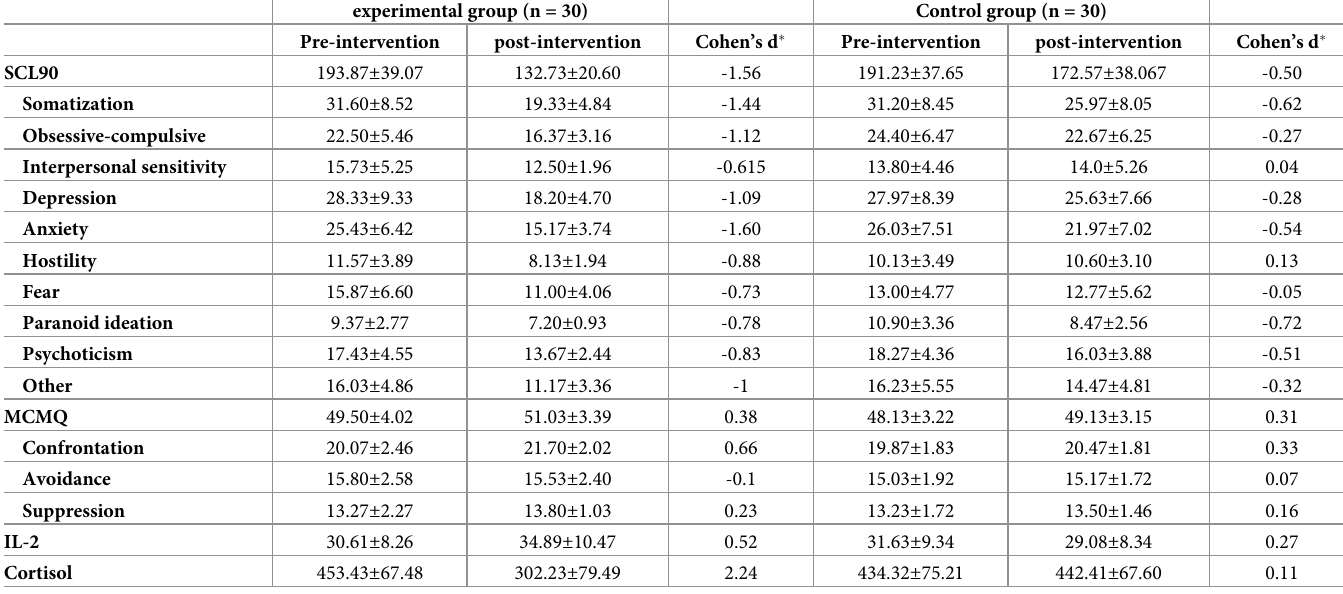
Table 5. Effect size of experimental and control group subjects’ pre- versus post-intervention